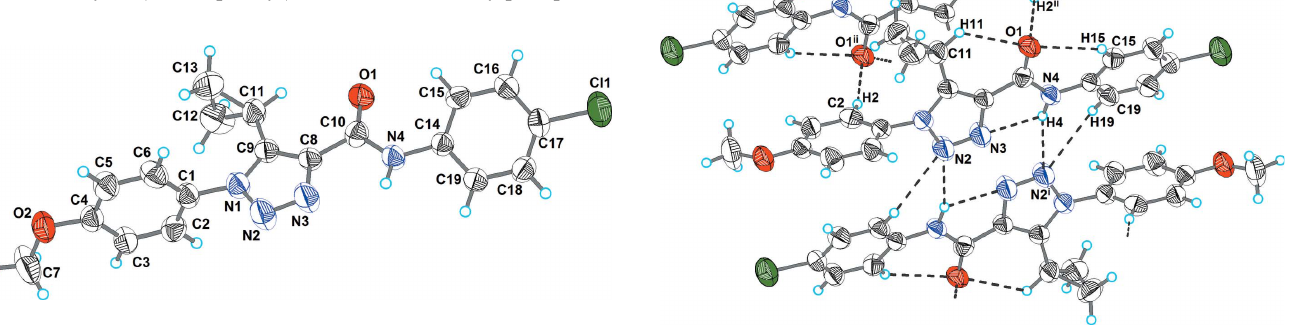
Figure 2 The hydrogen bonding of molecules in the title compound. Hydrogen bonds are shown as dashed lines. The symmetry codes are as in Table 1.